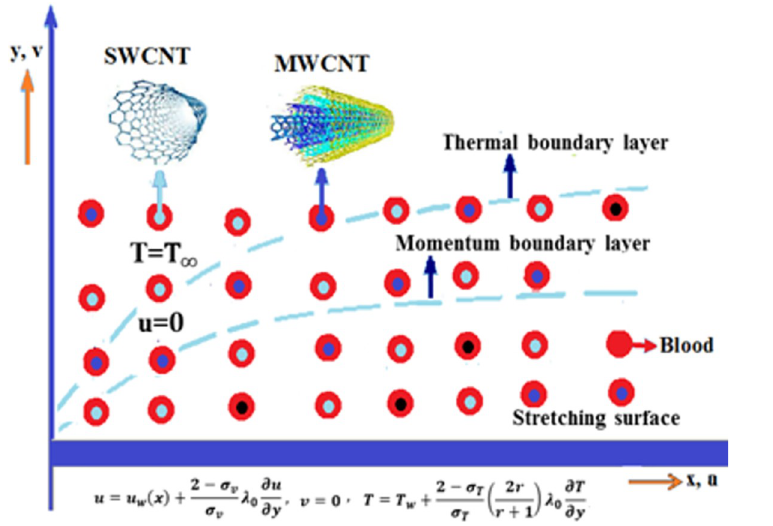
Fig 1. Physical description of flow model.